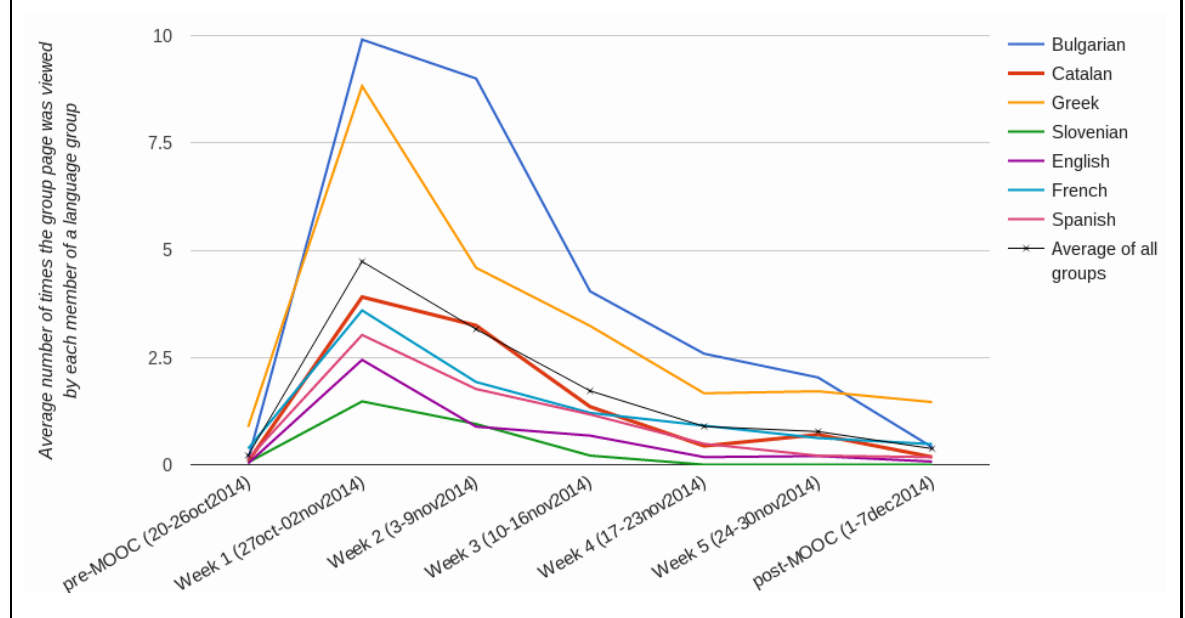
Figure 14. Group